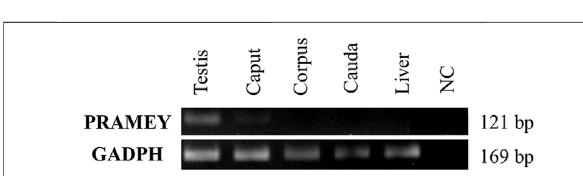
FIGURE4| Expressionanalysisofthebovine PRAMEY genebyRT-PCR in bovine testis and epididymal tissues (caput, corpus, and cauda). The liver RNA sample and water (no RNA) were used as negative controls (NC), while the expression of the GADPH gene was used as a positive control. PRAMEY was expressed speci fi cally in the testis, while no expression was observed in epididymal and liver tissues.